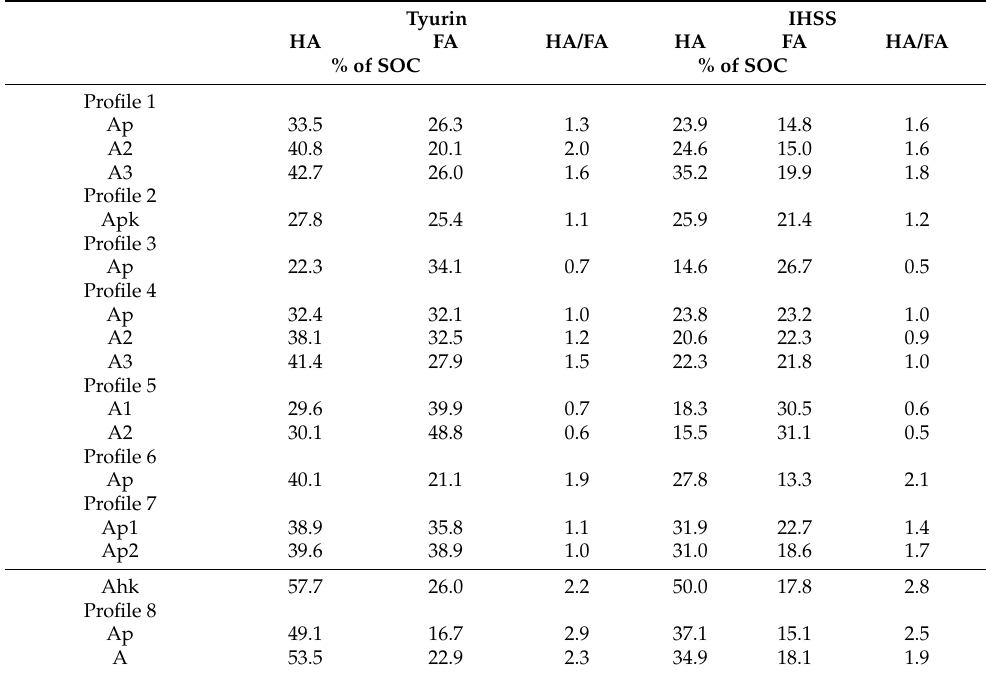
Table 3. Composition of humic substances extracted by Tyurin and IHSS